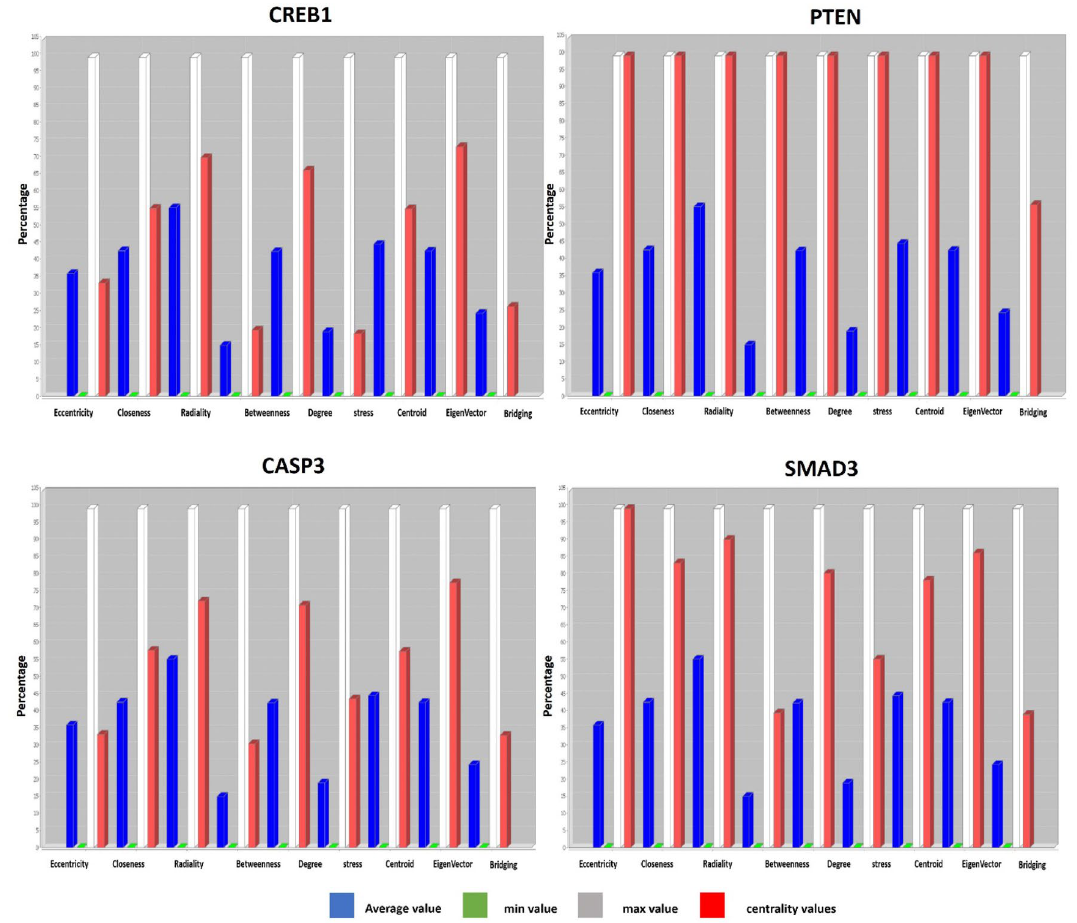
Figure 5. The network analysis of four most important hub genes by Centiscape plug-in. The Centiscape plug-in of Cytoscape software has represented the four most hub genes based on degree and betweenness centrality.